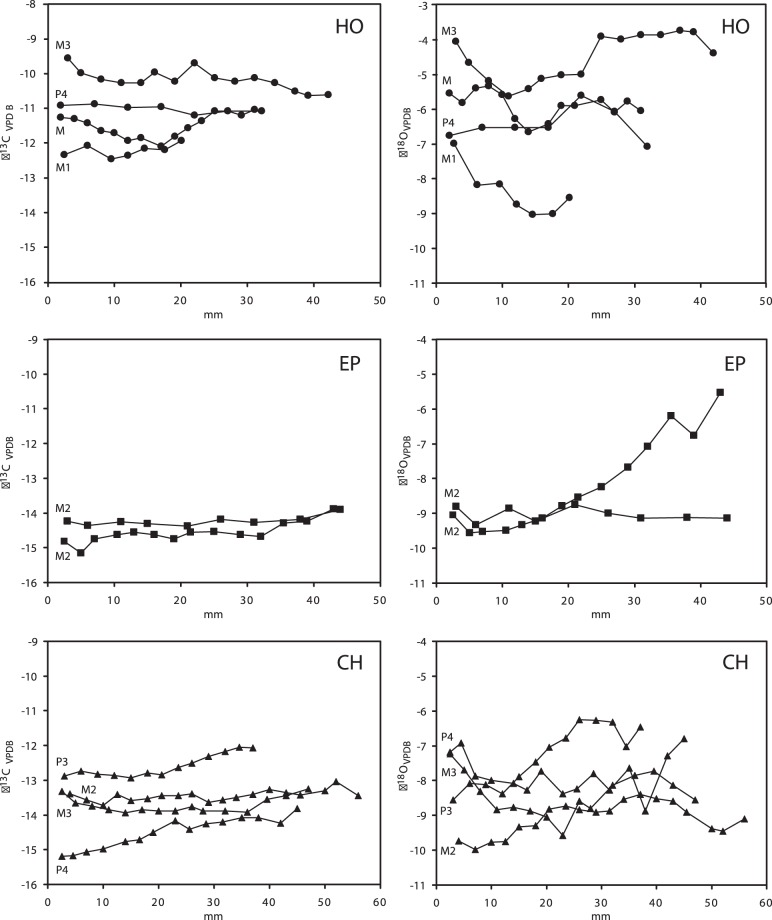
Intra-tooth variation of the enamel δ13C and δ18O values in 10 serially sampled teeth of Hippotherium primigenium molar and premolar teeth from Charmoille (CH), Eppelsheim (EP), and Höwenegg (HO).Samples are plotted against the distance from the crown in mm.